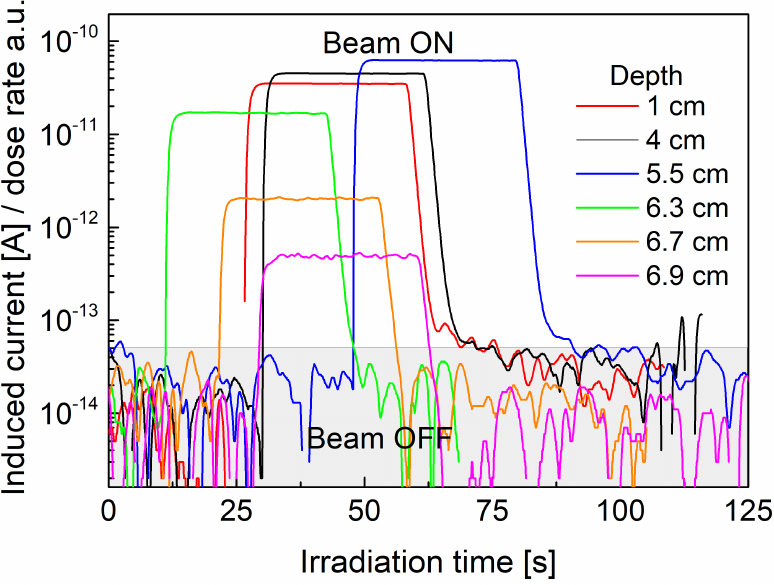
Figure 4. Proton beam-induced current in diamond GR microdosimeter at various depths of the plastic water